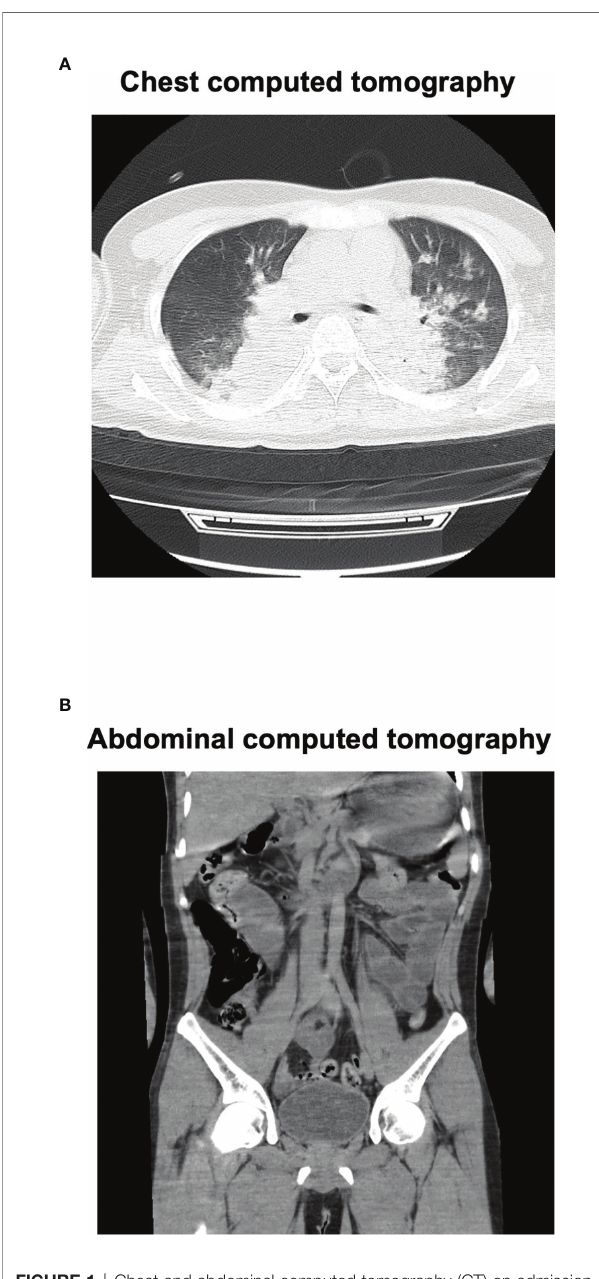
FIGURE 1 | Chest and abdominal computed tomography (CT) on admission. Chest CT (A) revealed marked pleural effusion and pulmonary edema. Abdominal CT (B) revealed marked intestinal edema.